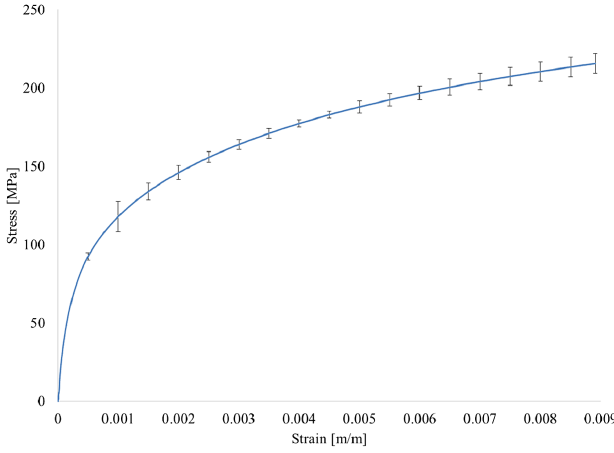
FIG. 18. Plot of compressive stress against strain for CuCD.